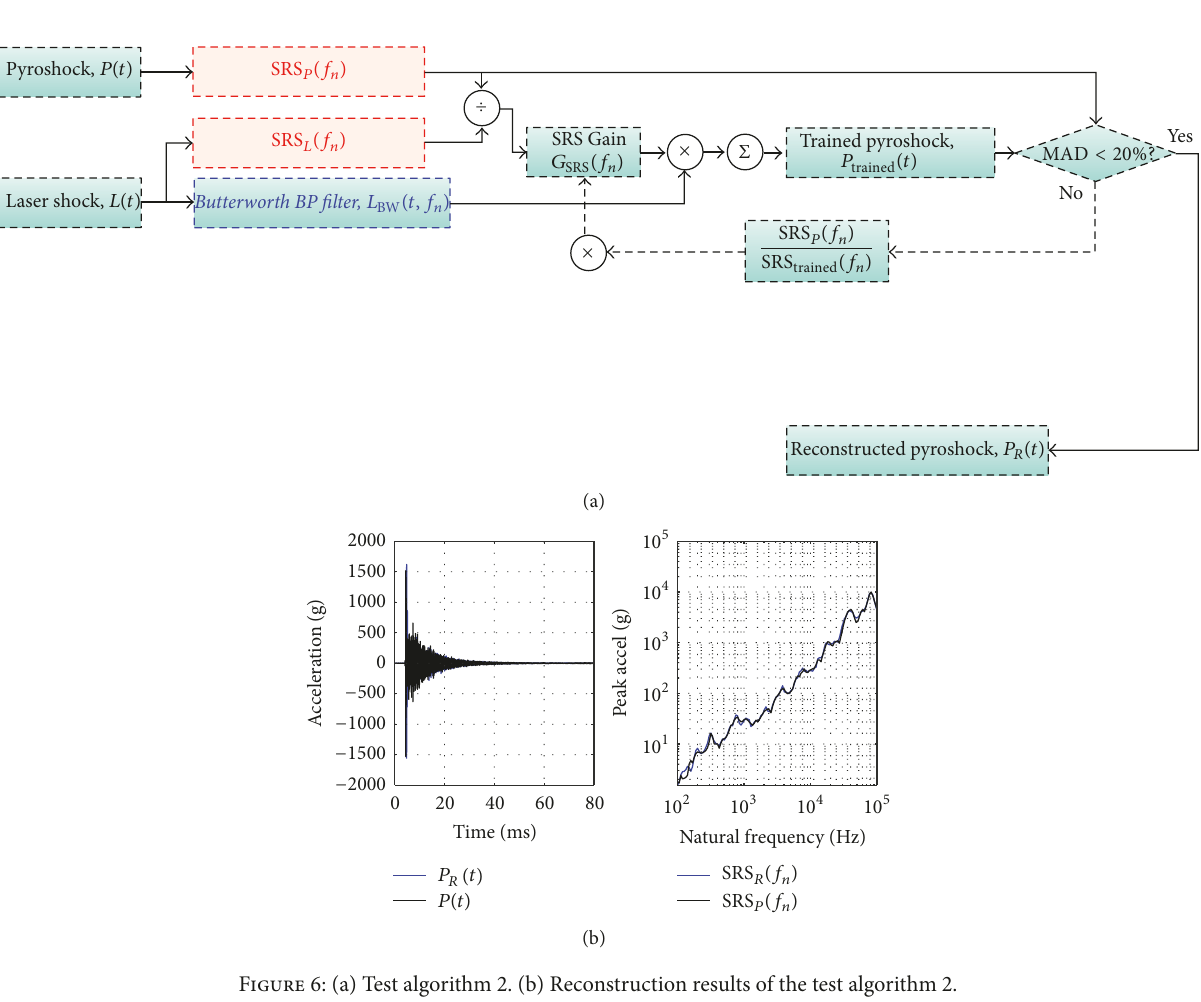
Figure 6: (a) Test algorithm 2. (b) Reconstruction results of the test algorithm 2.